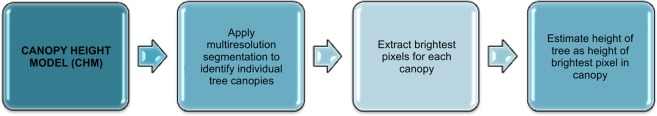
Extraction of Tree Height Values from LiDAR-derived CHM.